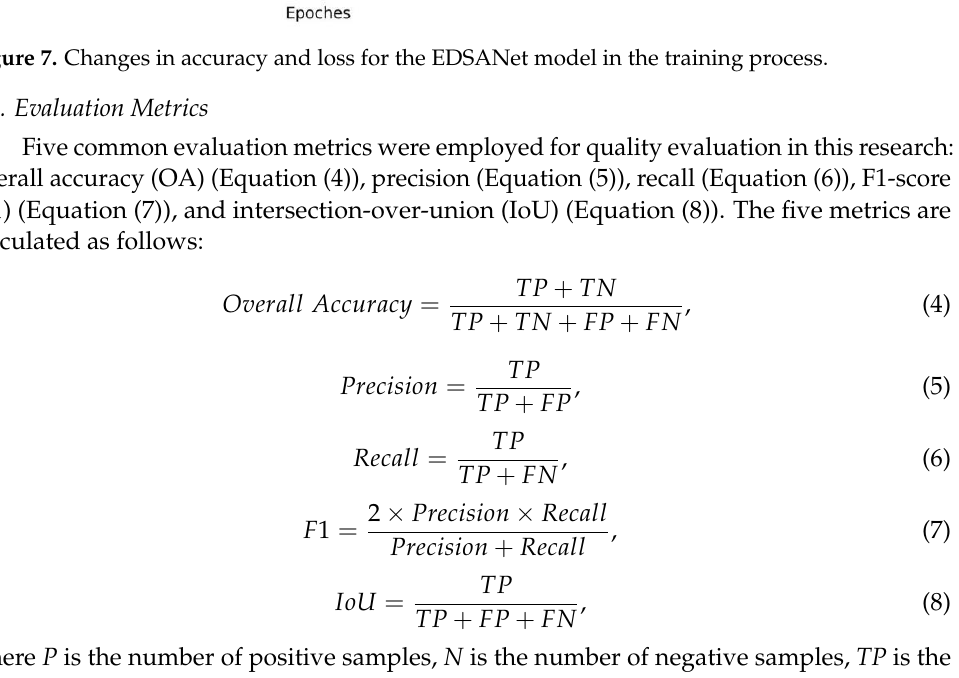
Figure 7. Changes in accuracy and loss for the EDSANet model in the training process.